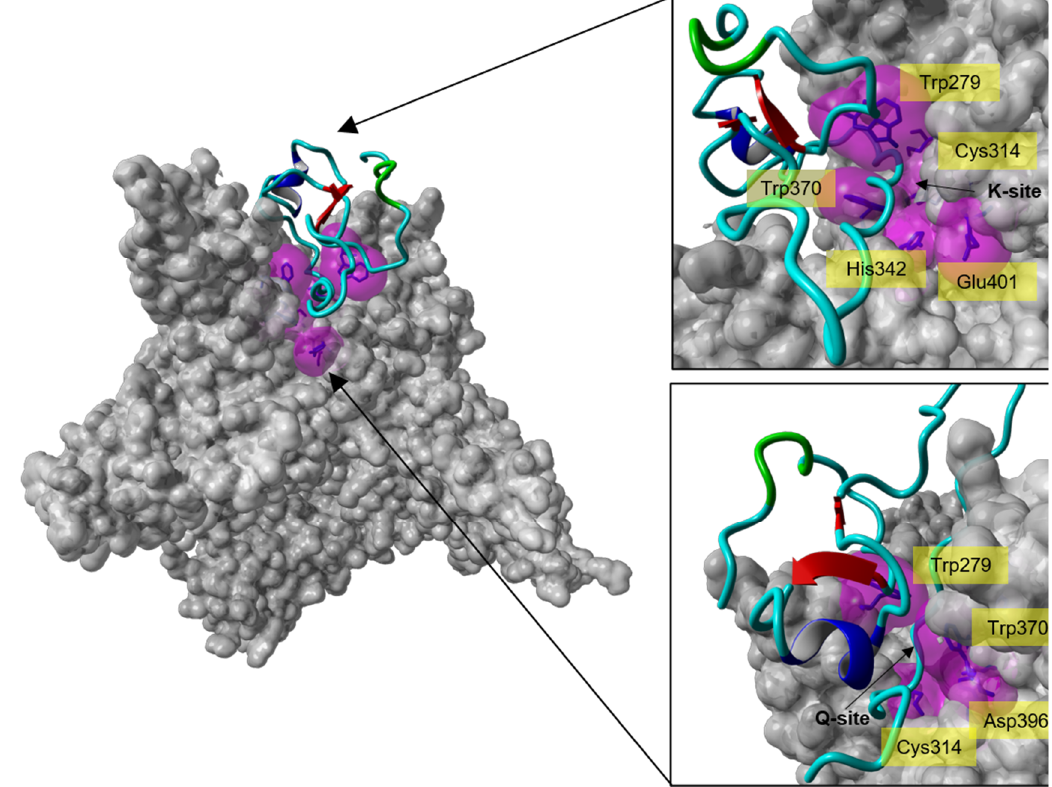
Figure 6: Molecular docking analysis of the interaction of isomer B [C19S,C25S] [29] with the catalytic site of FXIIIa. Left : Crystal structure of the calcium-activated FXIIIa-monomer (PDB ID: 4KTY [16], grey surface) docked with one of the top-ten-ranked conformations of isomer B [C19S,C25S] [29] (cyan ribbon), which interacts with the catalytic site of FXIIIa. Right : Zoom-in from different directions (lysine access site ( top , K-site) and glutamine access site ( bottom , Q-site)) of the FXIIIa active site interacting with isomer B [C19S,C25S] [29]. The active site residues of FXIIIa (Cys314, His373, Asp396, Trp279, and Trp370) are shown as blue sticks enclosed by their molecular surfaces (violet translucent surface).